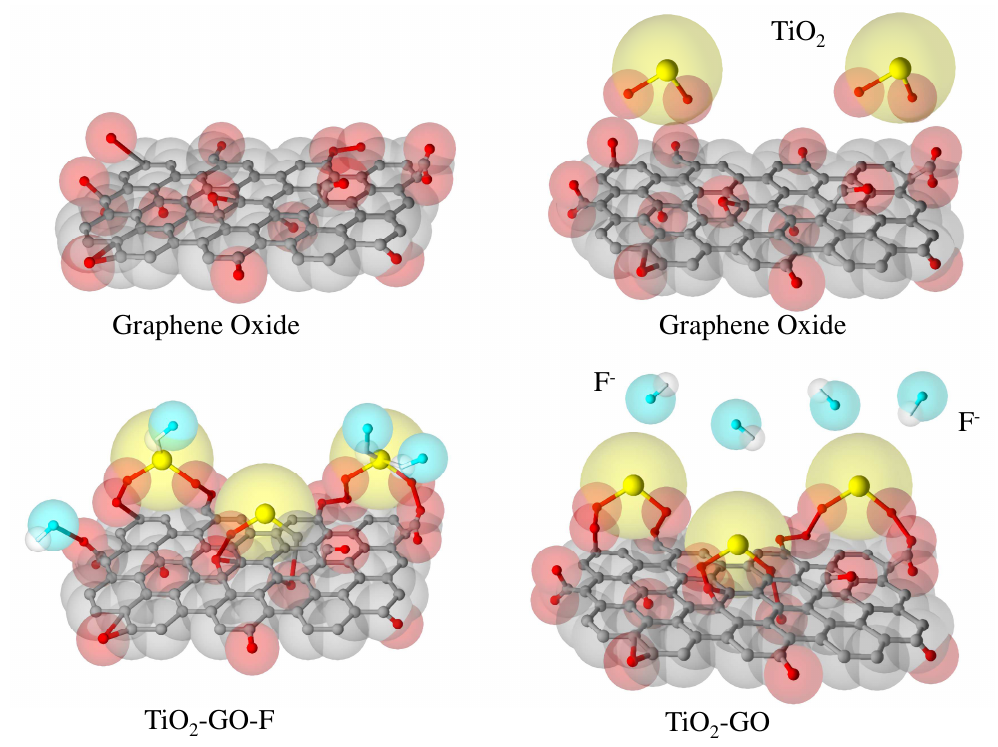
Figure 3. General representation of schematic synthesis of TiO 2 -GO nanocomposite and possible fluoride adsorption mechanism (figure adapted from Nehra et al. (2019) [74]). The schematic synthesis of TiO 2 -GO shows the nanocomposite and possible fluoride adsorption mechanism, and it describes the role of the hydroxyl groups in adsorption, producing an electrostatic attraction between the positively charged adsorbent and the negative F −